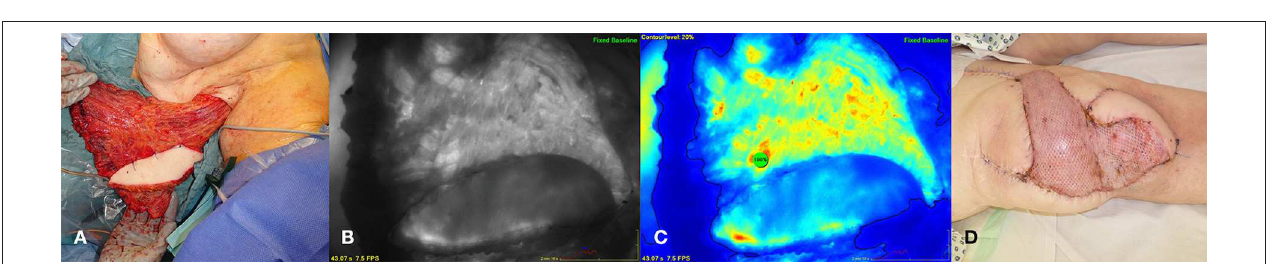
FIGURE 3 | Deep inferior epigastric perforator flap after complete harvesting at the abdomen based on a single lateral located perforator. (A) (left) ICG angiography showing the perfusion pattern on the contralateral side of the perforator across the midline. (B) (middle left) Analysis by using a contour level of 20% in relation to a reference point of maximum fluorescence within the flap. (C) (middle right) Color mode showing the surgeons hand marking the flap borders due to the ICG perfusion pattern. (D) (right) ICG angiography of the ipsilateral part of the flap indicating excellent perfusion.